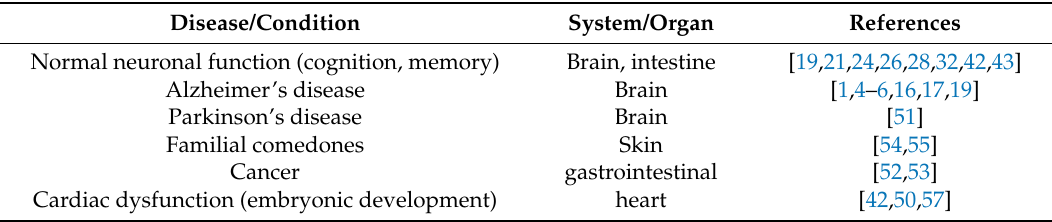
Table 2. Presenilin involvement in diseases and